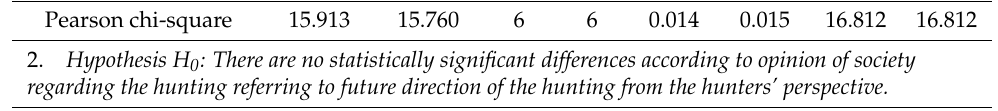
Table 6. The results and statistical hypotheses for the chi-square test. χ 2 Calculated df RO ES RO ES RO ES RO